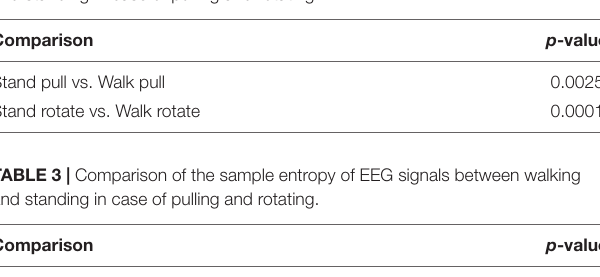
TABLE 2 | Comparison of the fractal exponent of EMG signals between walking and standing in case of pulling and rotating. Comparison p -value Stand pull vs. Walk pull Stand rotate vs. Walk rotate